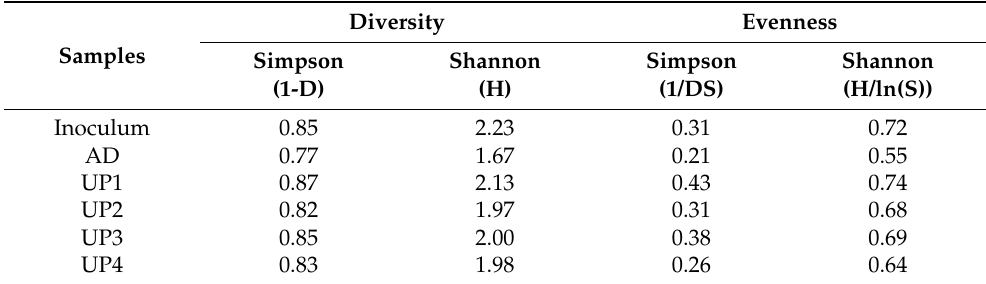
Table 4. Alpha diversity and evenness indices (Simpson and Shannon) of the bacteria community, calculated for all